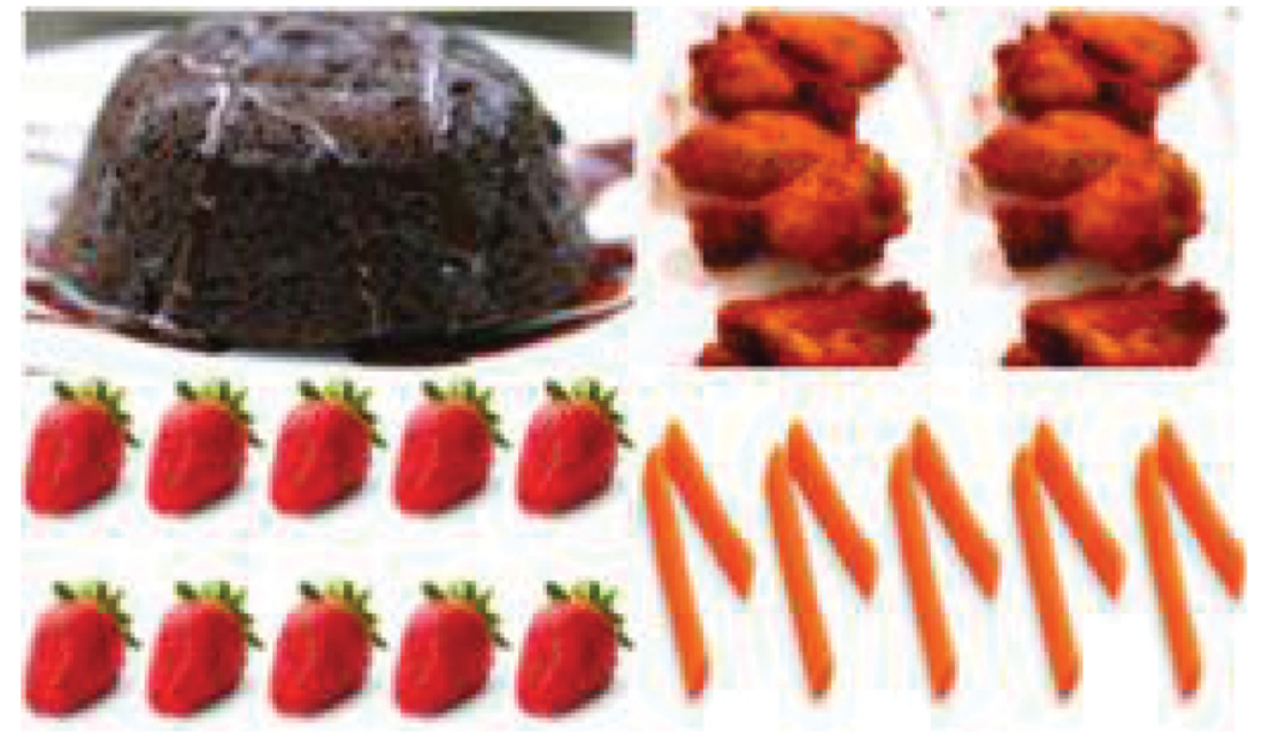
Fig 1. Food images shown for each delay discounting task. Each image shows the full portion. Next to each image was also a comparison photo of a single portion with either 1/10 of a slice of the cake, one chicken wing, one strawberry, or one carrot stick,